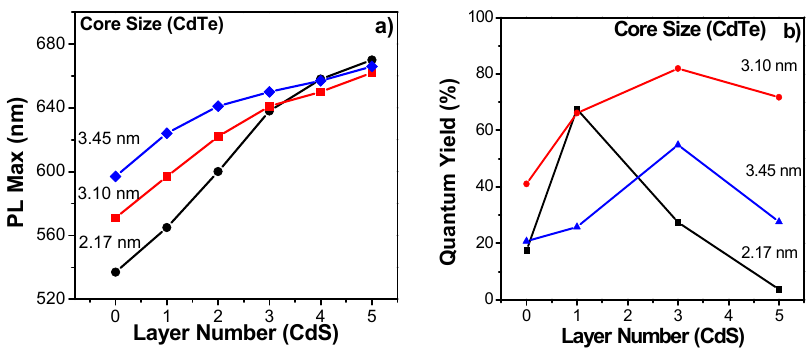
Figure 4. ( a ) Variation in the emission band positions and ( b ) fluorescence quantum yield values for the CdTe/CdS QDs obtained with CdTe nanocrystals of 2.17 nm, 3.10 nm, and 3.45 nm.